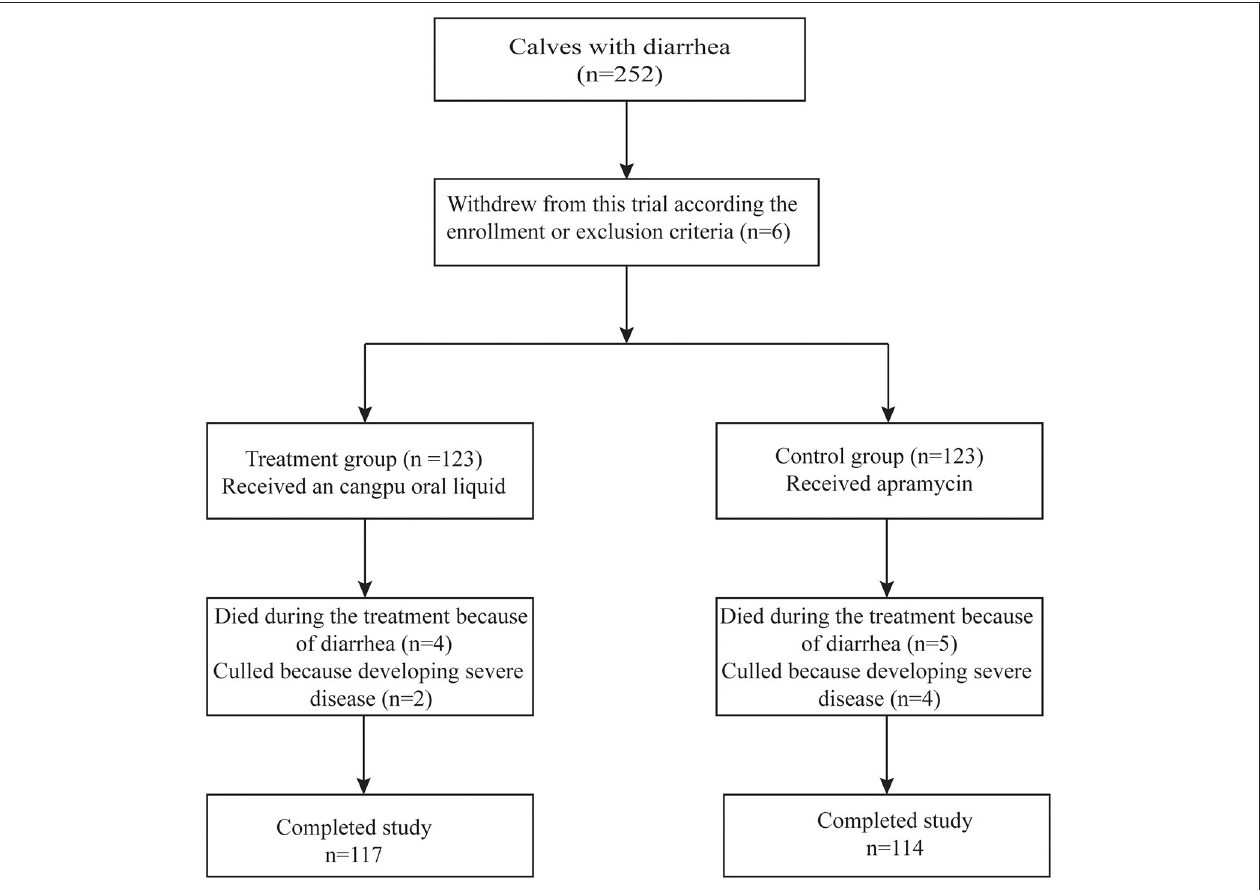
FIGURE 1 | Flow diagram showing the calves affected with diarrhea, randomization of calf with diarrhea, reasons for excluding calf from analyses, and completed study for statistical analysis.